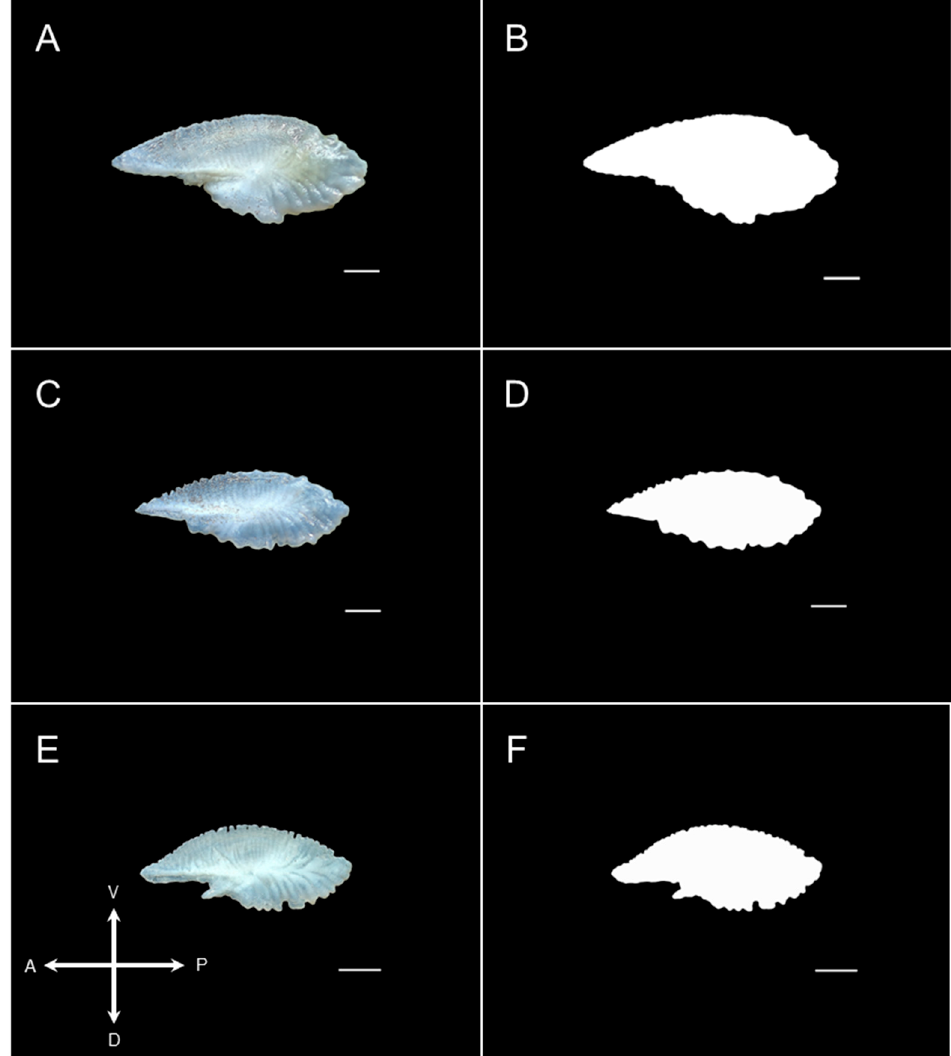
Figure 3. Raw and edited right sagittal otolith images of Decapterus kurroides —26.9 cm TL ( A , B ), D. smithvanizi —21.8 cm TL ( C , D ), and D. tabl —22.6 cm TL ( E , F ). The crossmap (lower-left) indicates the position of the otoliths: anterior (A); ventral (V); dorsal (D); posterior (P). Scale bar: 1 mm.